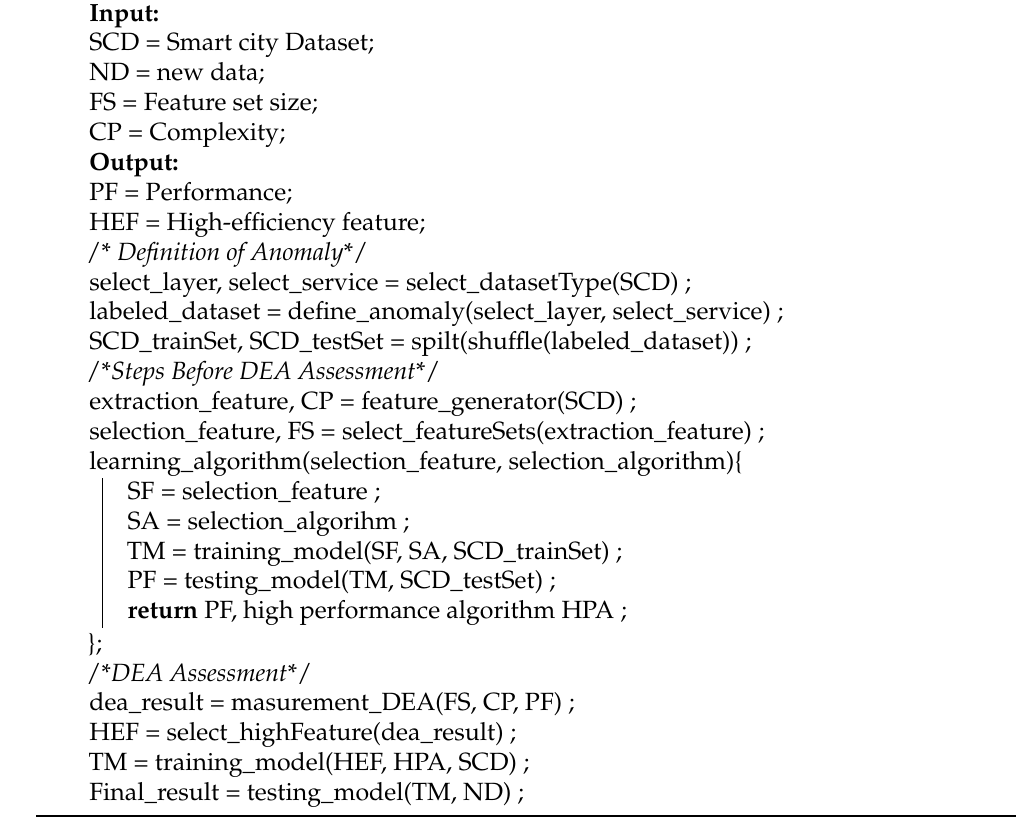
Algorithm 1: DEA based on the feature selection for anomaly detection